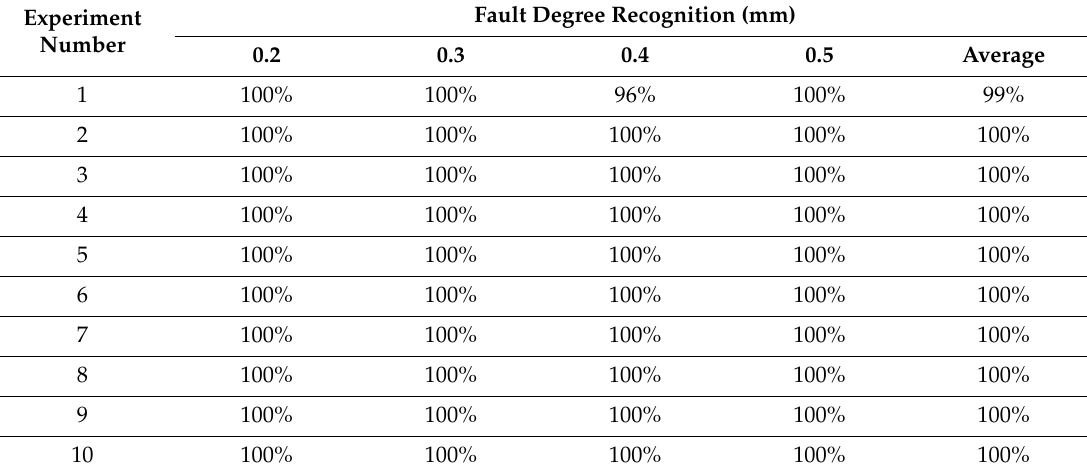
Table 6. Testing results of roller fault degree recognition by hierarchical fault diagnosis